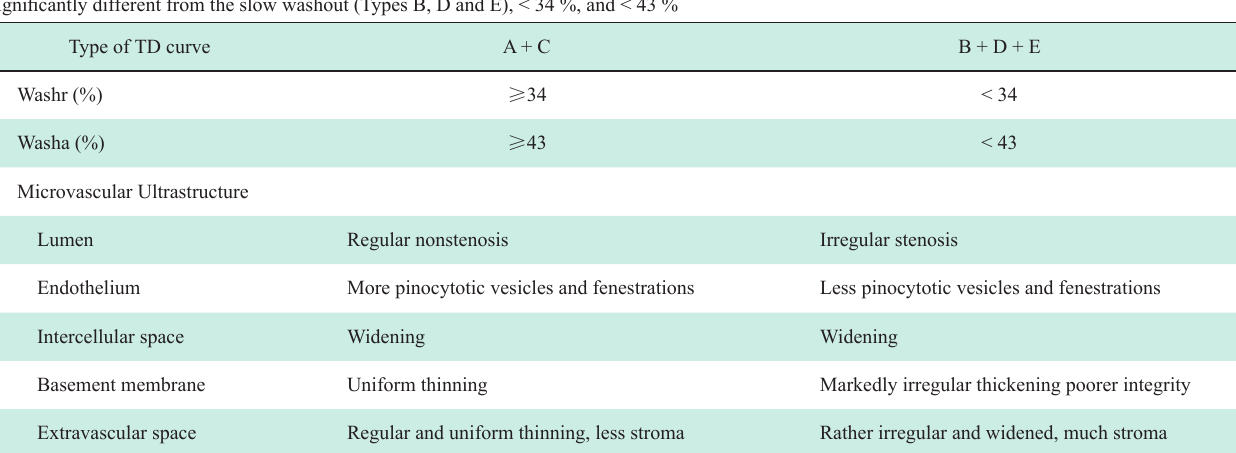
Table 4 The microvascular ultrastructure in the rapid washout (Types A and C), Washr ≥ 34%, and Washa ≥ 43% 7 - min delay timepoint was significantly different from the slow washout (Types B, D and E), < 34 %, and < 43 % Type of TD curve A + C B + D + E Washr